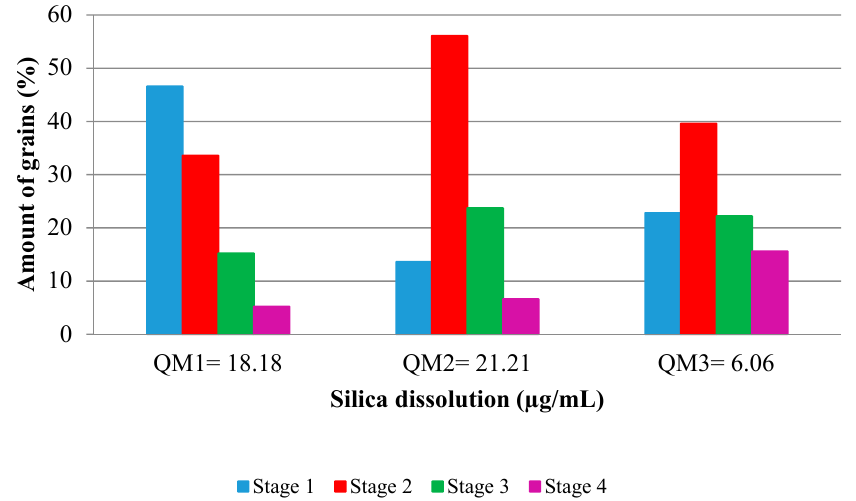
Figure 10. Relationship between silica dissolution and the deformation of the quartz.